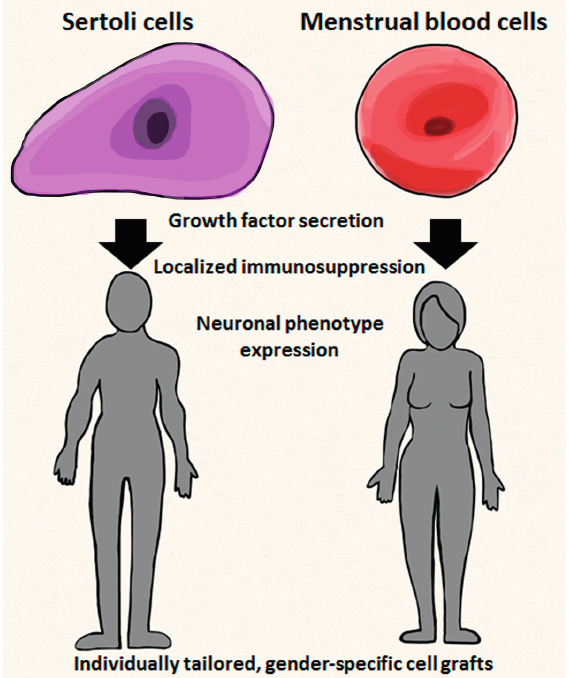
Figure 1. Sertoli cells and menstrual blood cells. Figure shows potential gender effects on stem cell biology such as growth factor secretion (both cells), localized immunosuppression (Sertoli cells) and neuronal phenotype expression (menstrual blood cells), as well as their therapeutic outcomes ( i.e. , individually tailored, gender-specific cell